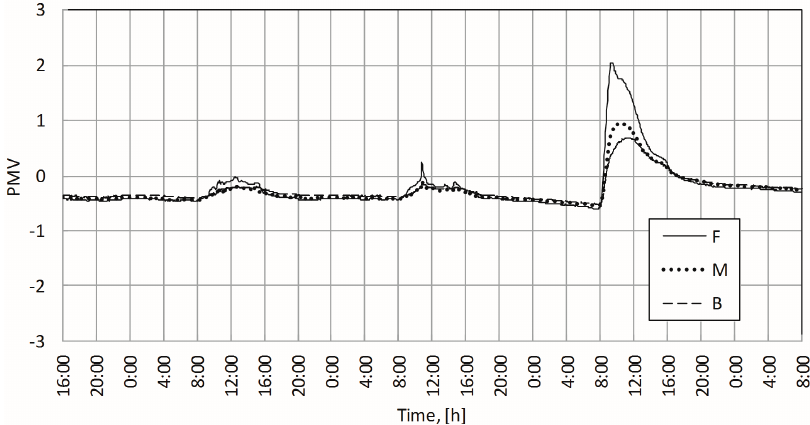
Figure 8. PMV values in the office for three consecutive days.